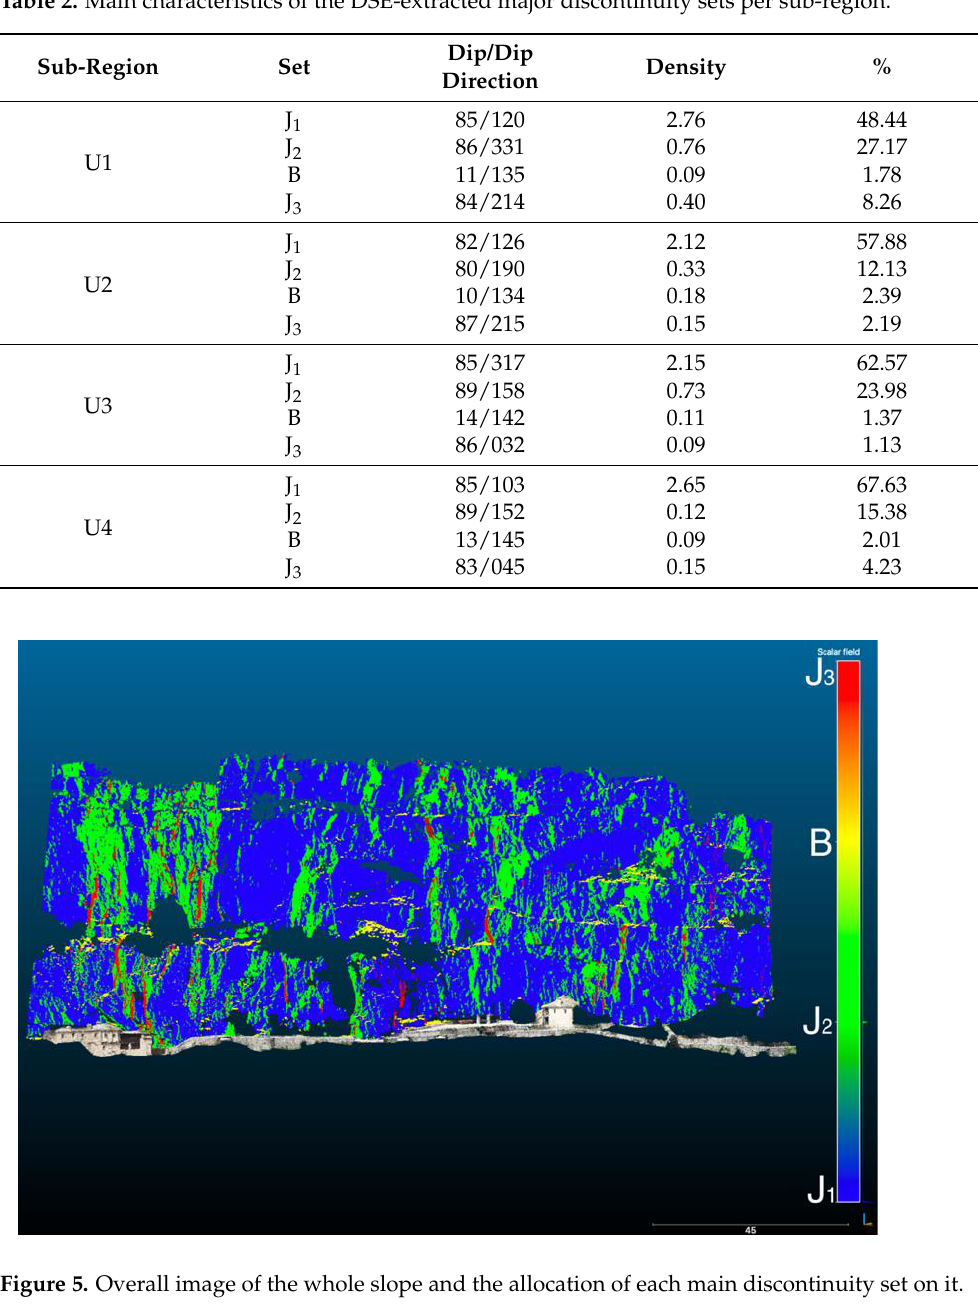
Table 2. Main characteristics of the DSE-extracted major discontinuity sets per sub-region.